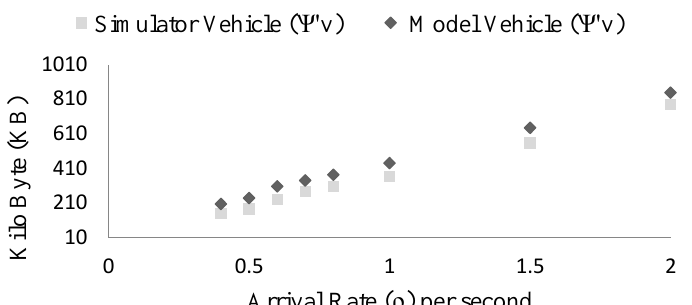
Figure 13. Comparison of the simulation and the model based vehicle storage requirements at different arrival rate ( ρ ).